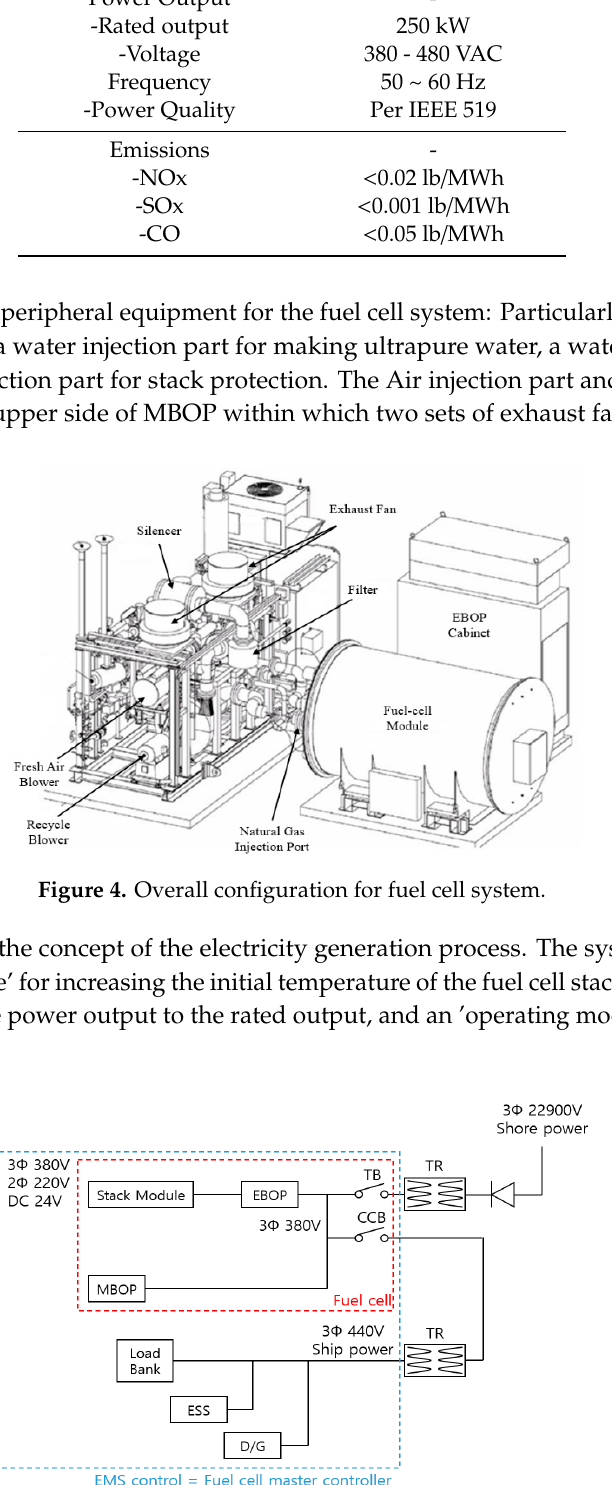
Table 1. Specification of the fuel cell system.